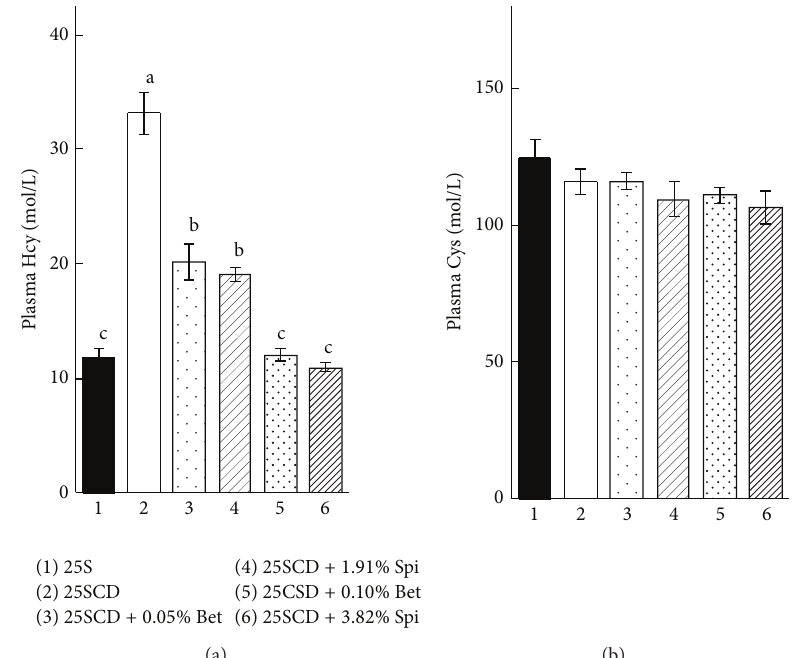
Figure 5: Plasma homocysteine (a) and cysteine (b) concentrations in rats fed the experimental diets (experiment 2). Each value is the mean ± SEM, 𝑛 = 6 . Values in a panel without a common letter differ at 𝑃 < 0.05 . 25S, 25% soybean protein diet; 25SCD, choline-deprived 25S. See the caption of Figure 2 for other